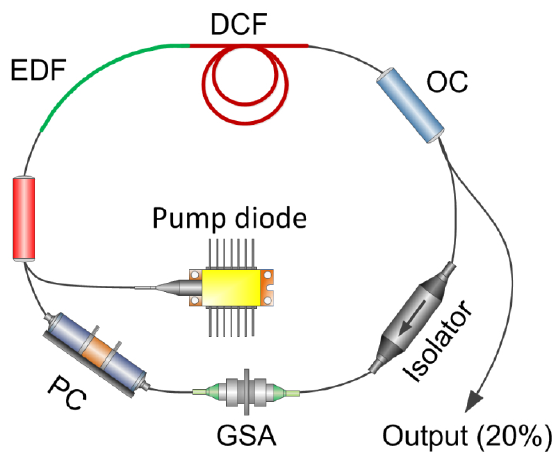
Figure 4. The setup of the stretched-pulse Er-doped mode-locked fiber laser (EDF—erbium-doped fiber; DCF—dispersion compensation fiber; OC—output coupler; GSA—graphene saturable absorber; PC—polarization controller). Reproduced from ref. [58]. Optical Society of America, 2015.